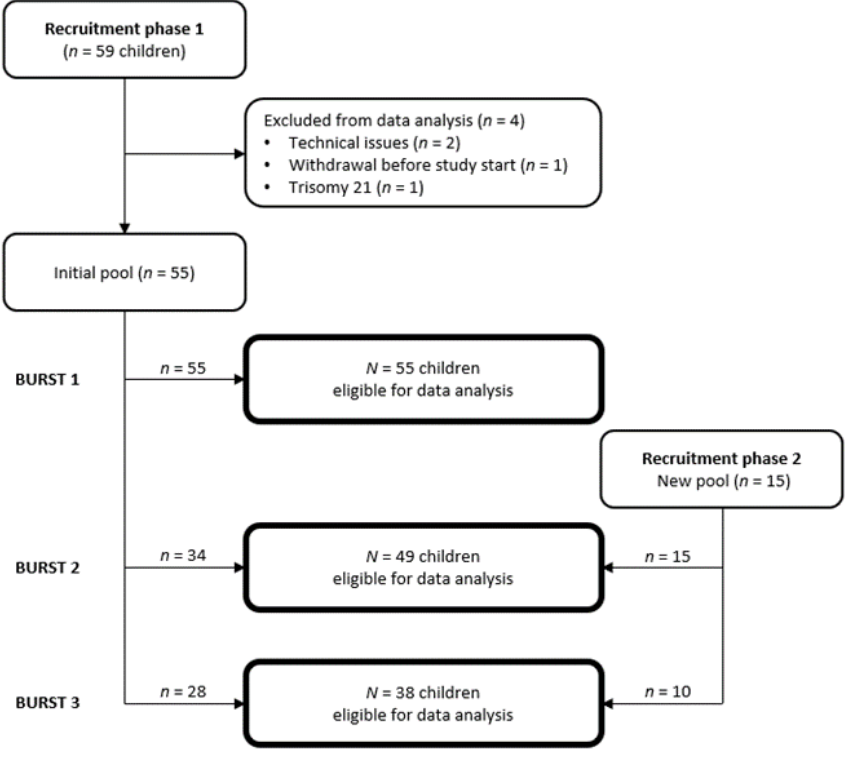
Figure 1. Recruitment process and retention of the